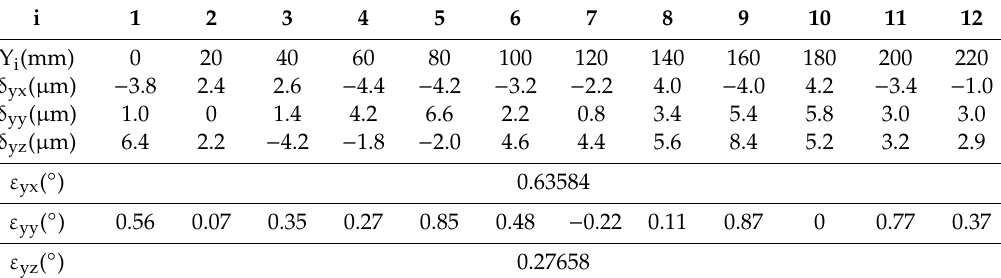
Table A2. Complete geometric errors of the